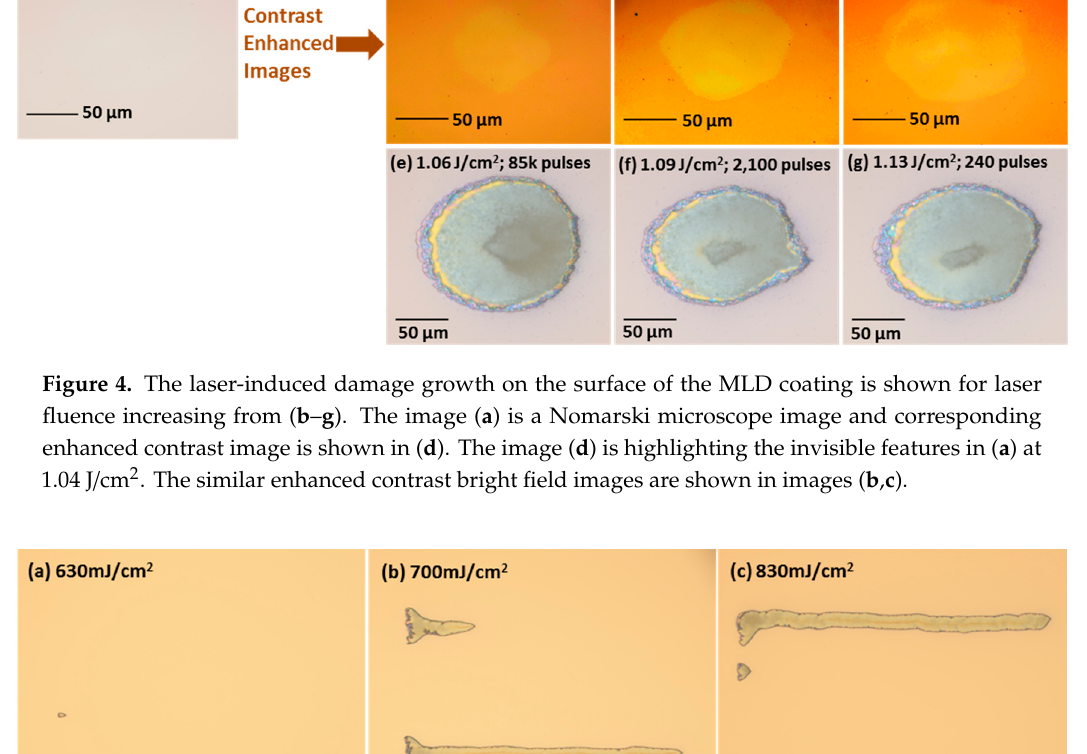
Figure 4. The laser-induced damage growth on the surface of the MLD coating is shown for laser fluence increasing from ( b – g ). The image ( a ) is a Nomarski microscope image and corresponding enhanced contrast image is shown in ( d ). The image ( d ) is highlighting the invisible features in ( a ) at 1.04 J/cm 2 . The similar enhanced contrast bright field images are shown in images ( b , c ).